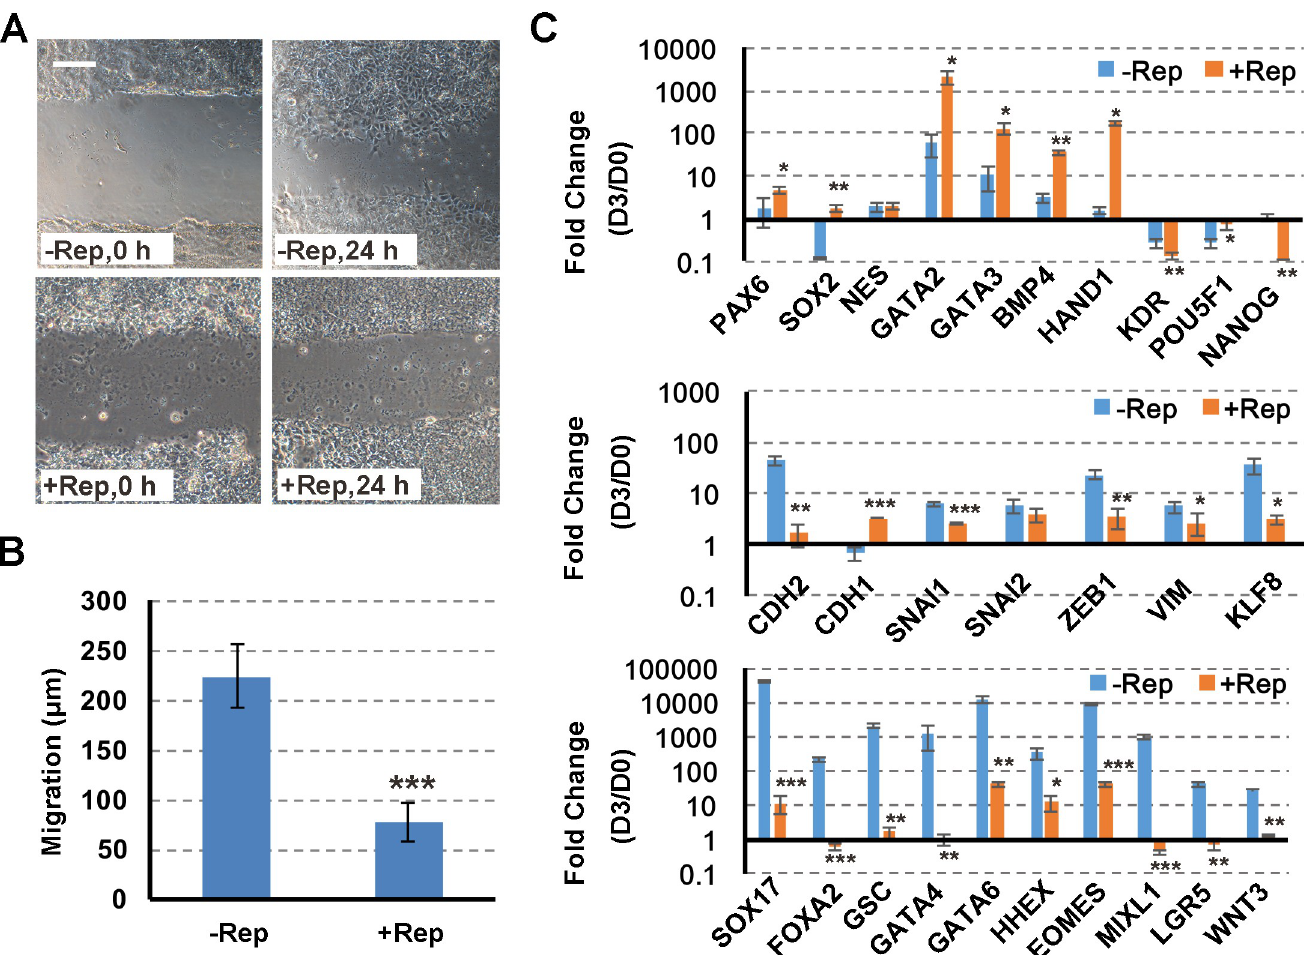
Fig 2. Inhibition of TGF- β signaling after PS induction blocks the EMT but promotes ectoderm/mesoderm cell fates. (A, B) Scratch assays for activin A-induced cells with or without Repsox (Rep) treatment. The scale bar indicates 100 μ m. Shown, are the means ± s.d. of three technical replicates. ��� P < 0.001, compared to the control. (C) RT-qPCR analysis for the indicated genes with or without Repsox (Rep) treatment. Shown are the means ± s.d. of three replicates. � P < 0.05; �� P < 0.01; ��� P < 0.001, compared to the control.